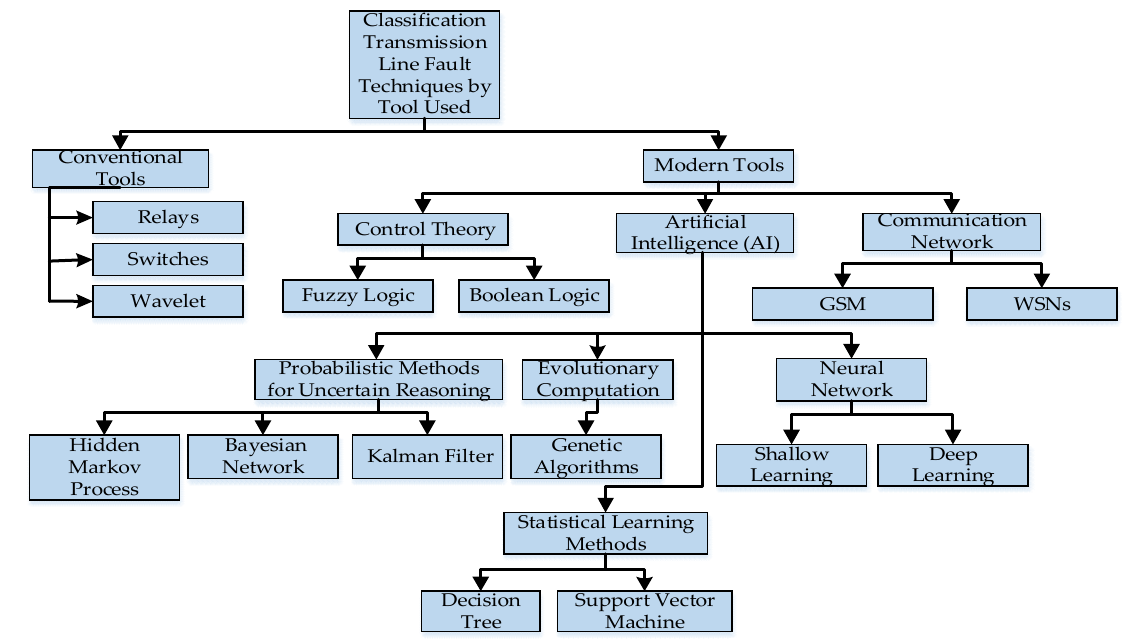
Figure 5. Classification of fault analysis techniques based on the method used.